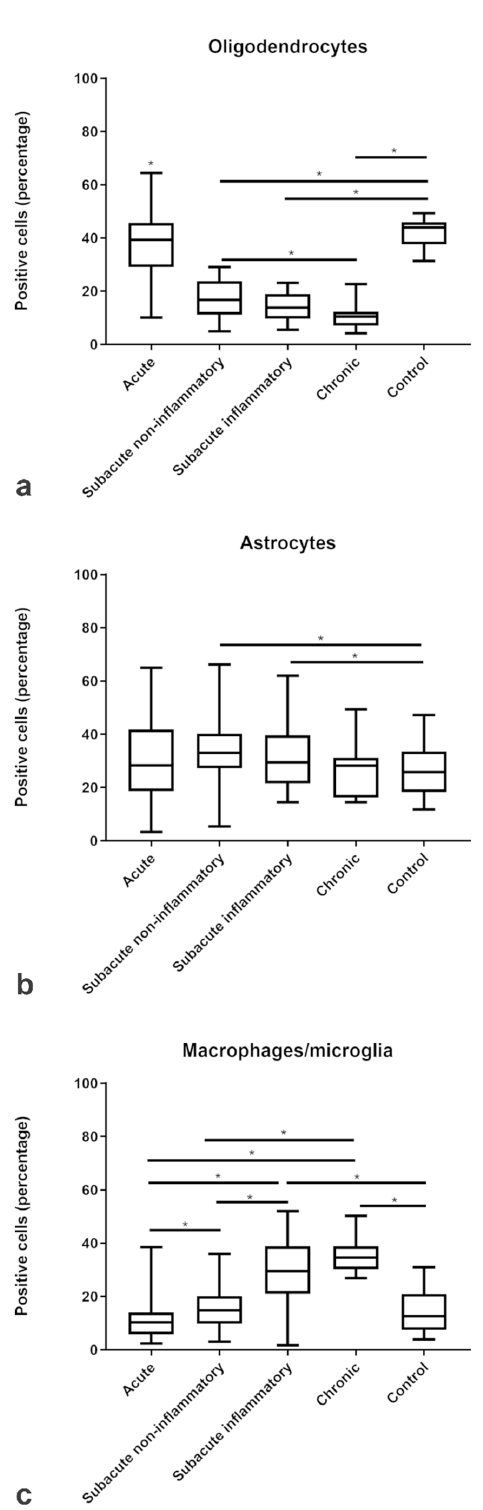
Figure 2. Relative changes in the proportions of ( a ) oligodendrocytes, ( b ) astrocytes, and ( c ) macrophages / microglia as compared to total intralesional cell counts in the di ff erent subgroups of CDV-DL and controls as assessed by immunohistochemistry for CNPase, GFAP, and Iba-1, respectively. Significant di ff erences between the groups as revealed by the Kruskal–Wallis test with independent pairwise post-hoc Mann–Whitney U-test are marked with an asterisk (* p ≤